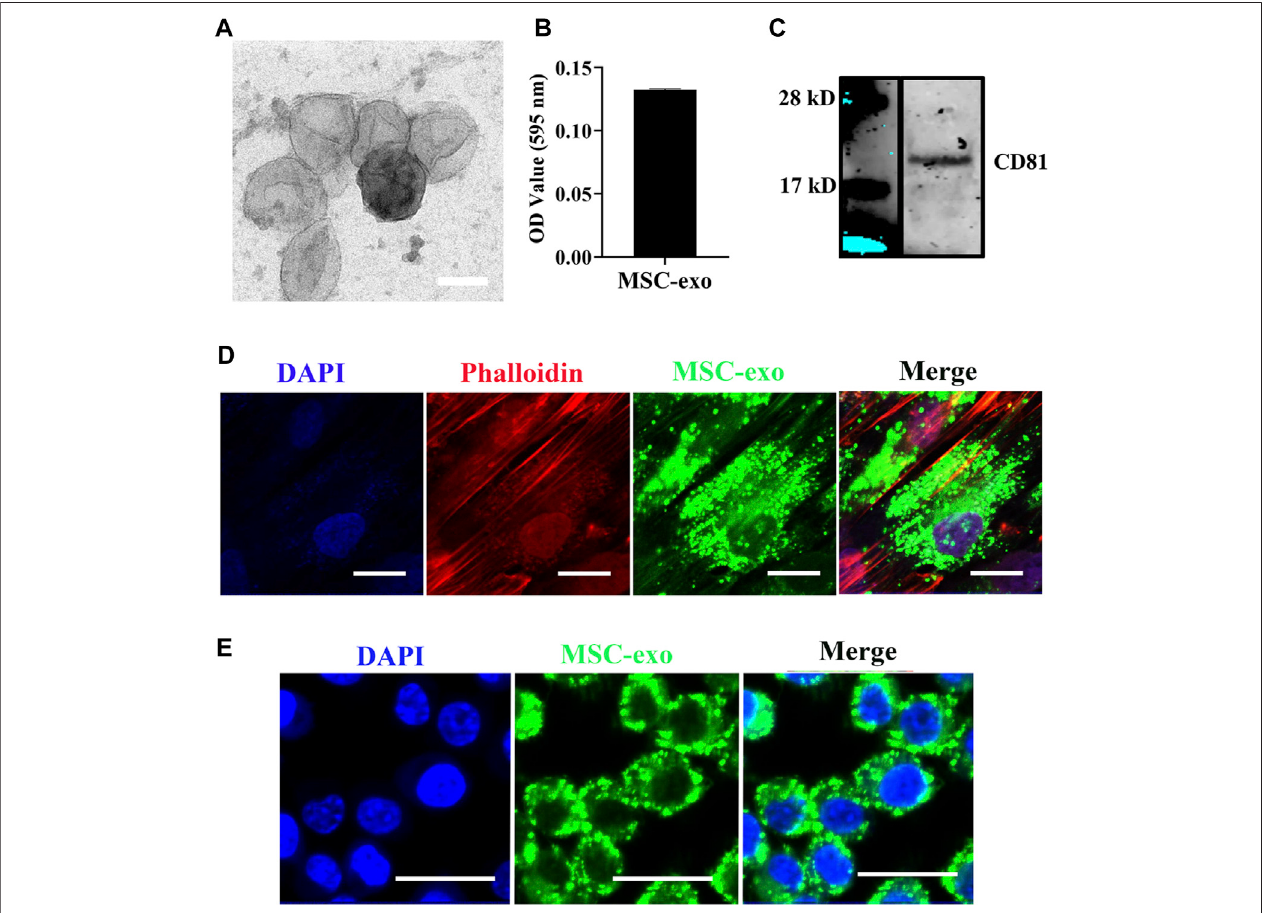
FIGURE1| hBMSC-derivedexosomeisolationandcharacterization. (A) RepresentativeTEMimagesofexosomesisolatedfromMSCs.Exosomeswerenegativelystained with 1% uranyl acetate and examined by TEM. Scale bars (cid:2) 80 nm. (B) Quanti fi cation of the exosomal protein level. Protein quanti fi cation was assessed using the Pierce BCA Protein Assay. Data were expressed as mean ± SD ( n (cid:2) 3). (C) Western blot of the exosomal surface marker. Expression of CD81 was evaluated by western blotting. (D) Internalization of hBMSC-derived exosomes into hBMSCs. hBMSC-derived exosomes were labeled with the exosome labeling marker, PKH67, and then incubated with hBMSCs overnight at 37 ° C. Cells were stained with the cytoskeleton (red) and nucleus (blue) ( n (cid:2) 3). Scale bars (cid:2) 20 μ m. (E) Internalization of hBMSC-derived exosomes into macrophages. hBMSC-derivedexosomeswerelabeledwiththeexosomelabelingmarker, PKH67,andthen incubated with RAW264.7 overnightat 37 ° C. Scalebars (cid:2) 20 μ m.